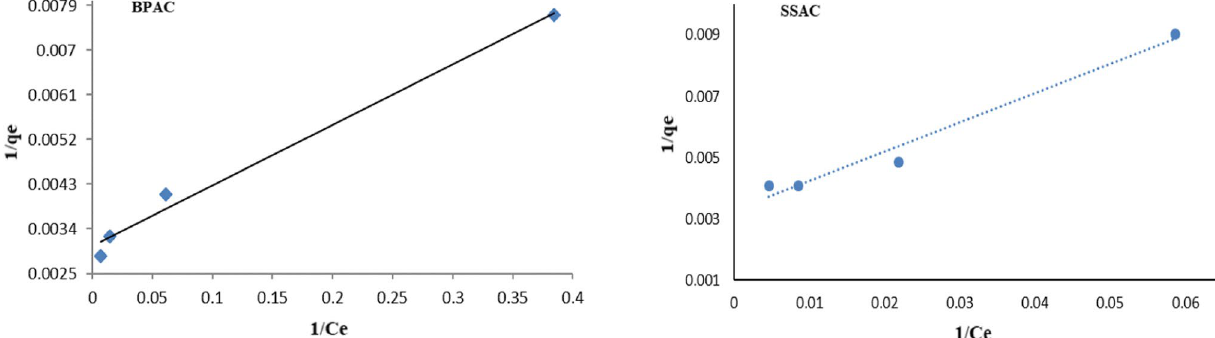
Fig. 8 Langmuir isotherm models of adsorption BB41 by PBAC and SSAC